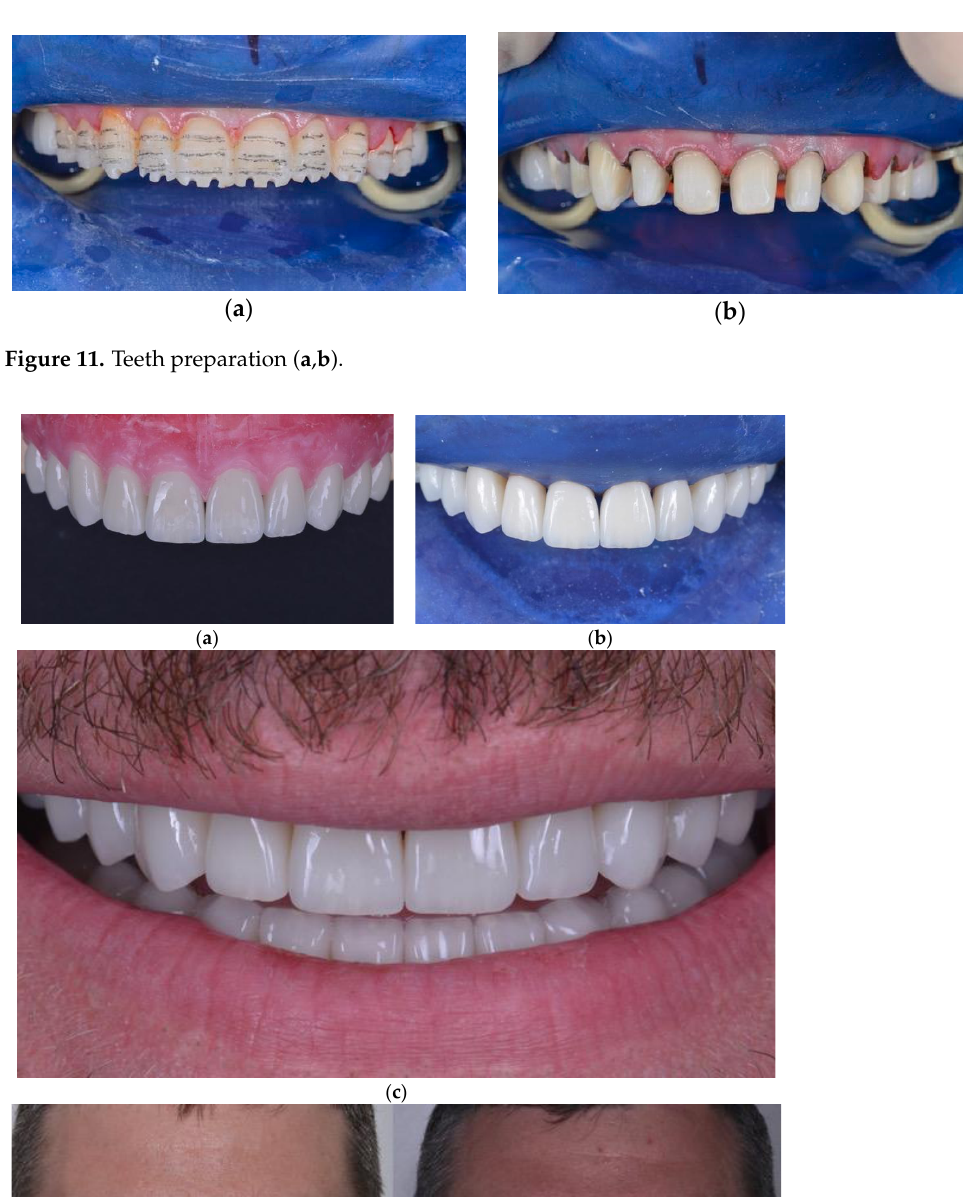
( b ) Figure 9. Intra-oral smile view before ( a ) and after ( b ) teeth alignment. ( a ) ( b ) Figure 10. Frontal ( a ) and occlusal ( b ) view of teeth mock-up. The mock up was created using silicon indexes and Luxatemp (DMG) material for temporaries and Luxaflow (DMG) for bonding. The patient wore the mock-up and ac- cepted the planned shape of teeth. The mock-up changed not only the shape of the teeth but also the occlusal vertical dimension. Assessing the clinical acceptance of treatment, the prosthodontist performed the teeth preparation (Figure 11). Then, the manufacture of prosthetic dentures was per- formed, giving group guidance to prevent overloading. Ceramic prosthetics were manu-